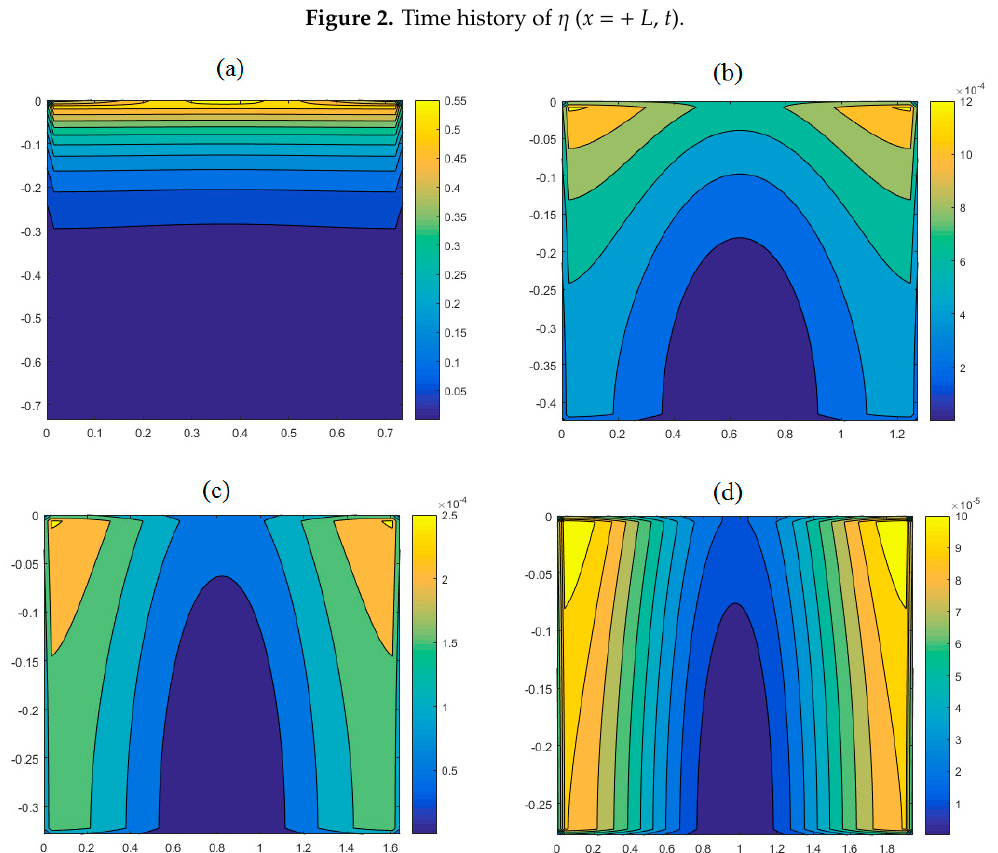
Mathematics 2019 , 7 , x